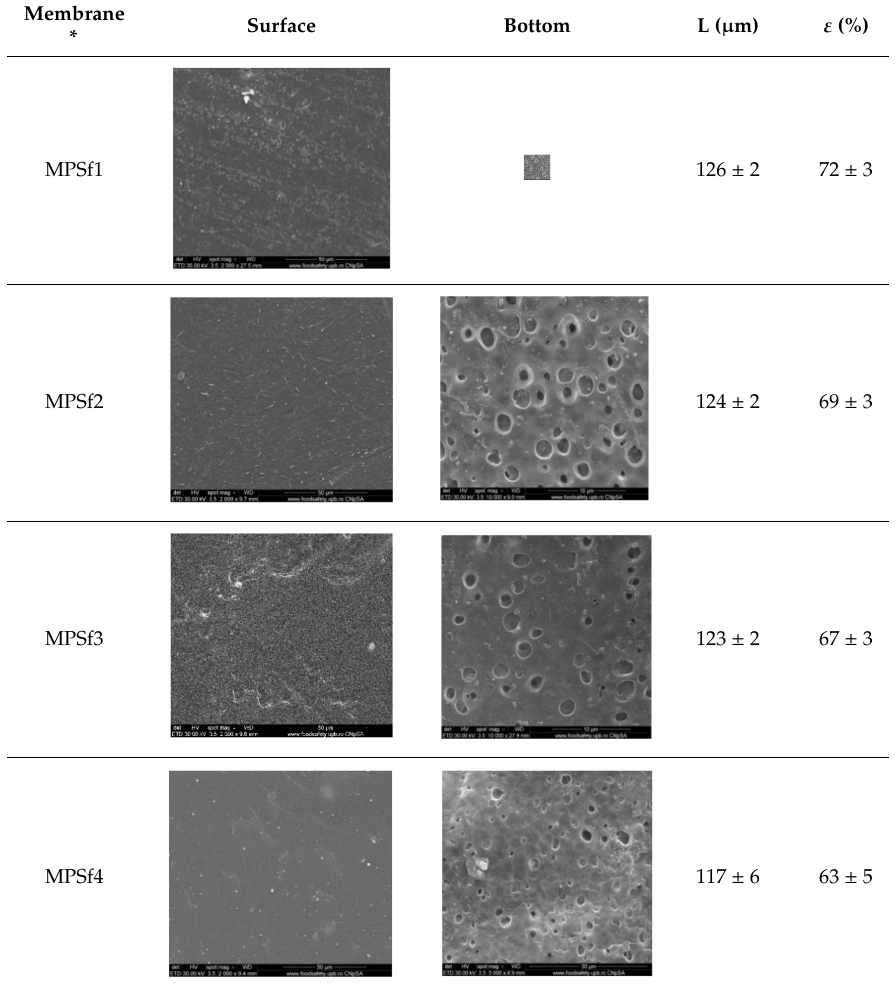
Table 1. Morphology of the surface, posterior surface porosity, average thickness, and porosity of the membranes obtained.